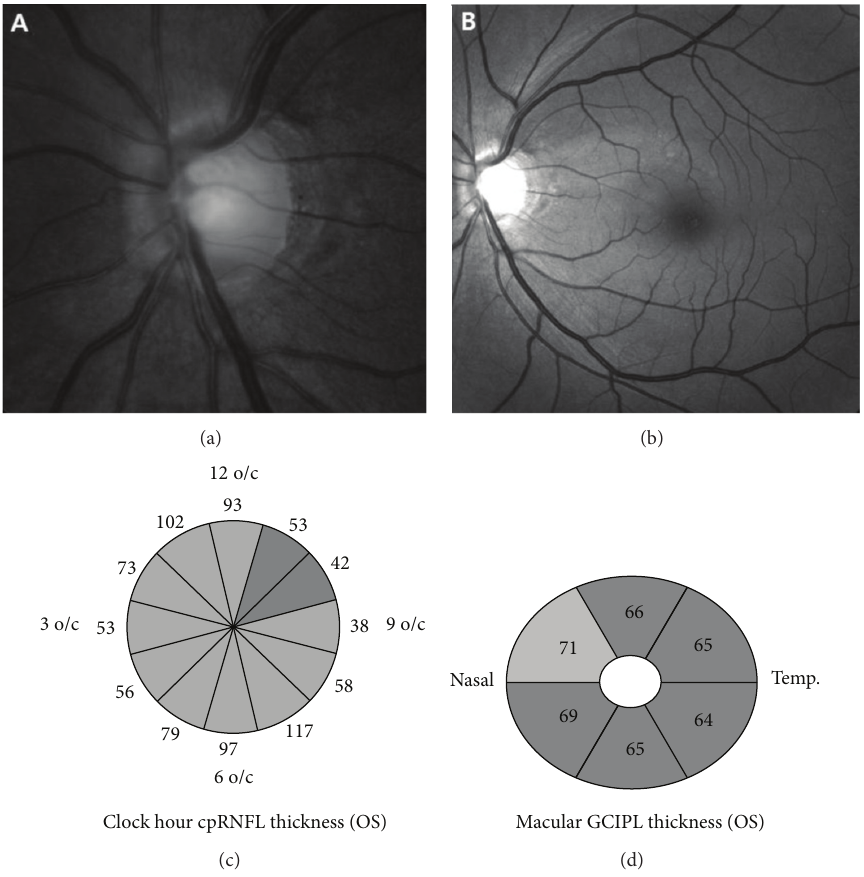
Figure 2: An example of an eye with normal tension glaucoma (NTG) with superior retinal nerve fiber layer (RNFL) defect in a 46-year-old male patient. (a, b) Color fundus photograph and red-free retinal nerve fiber layer (RNFL) photograph of the left eye show optic disc rim thinning and RNFL defect in the superotemporal segment. (c) Optical coherence tomography (OCT) shows definite thinning of RNFL in the superotemporal segment. (d) Macular analysis in OCT shows generalized thinning of ganglion cell inner plexiform layer (GCIPL) in all